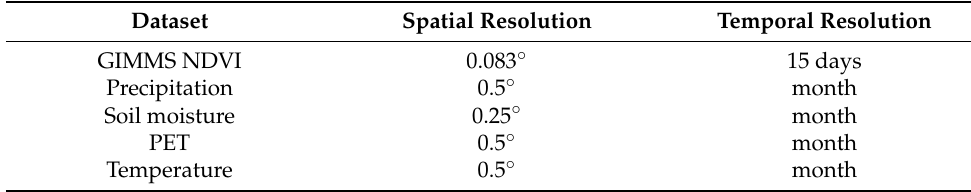
Table 1. Specific parameters of NDVI and climate elements. Dataset Spatial Resolution Temporal Resolution GIMMS NDVI 0.083 ◦ 15 days Precipitation 0.5 ◦ month Soil moisture 0.25